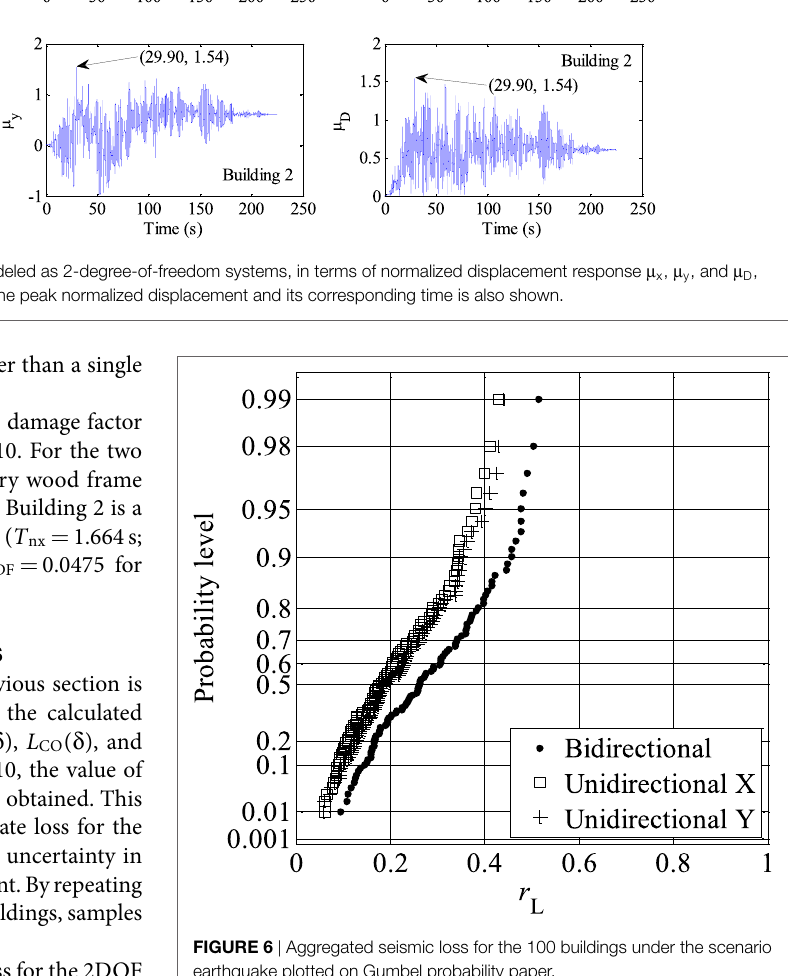
By repeating the analysis for the building modeled as SDOF systems and subjected to the same set of excitations along the X - axis used in 2DOF system case, samples of L are obtained and also presented in Figure 6 . The results follow Gumbel distribution well with a median value of 0.18. Similar analysis is also carried out for Y -axis; the results are also plotted in Figure 6 . Comparison of the results for SDOF systems under unidirec- tional excitations versus 2DOF systems subjected to bidirectional excitations indicate that the simplification of using unidirectional excitations and SDOF models can underestimate the aggregated seismic loss in a scenario earthquake event. Such